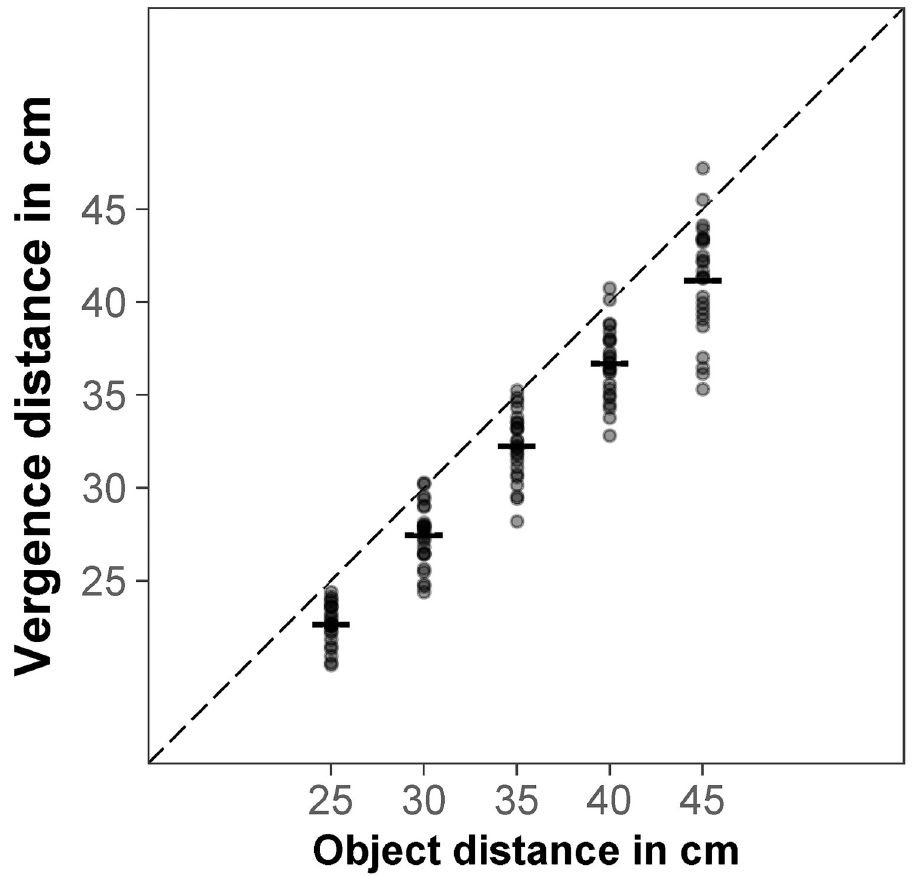
Fig 2. Vergence distance in congruent trials. Mean vergence distance for object distance; each data point represents the median for one participant (aggregated over six objects); the dashed black line represents the object distance as specified by binocular disparity and familiar